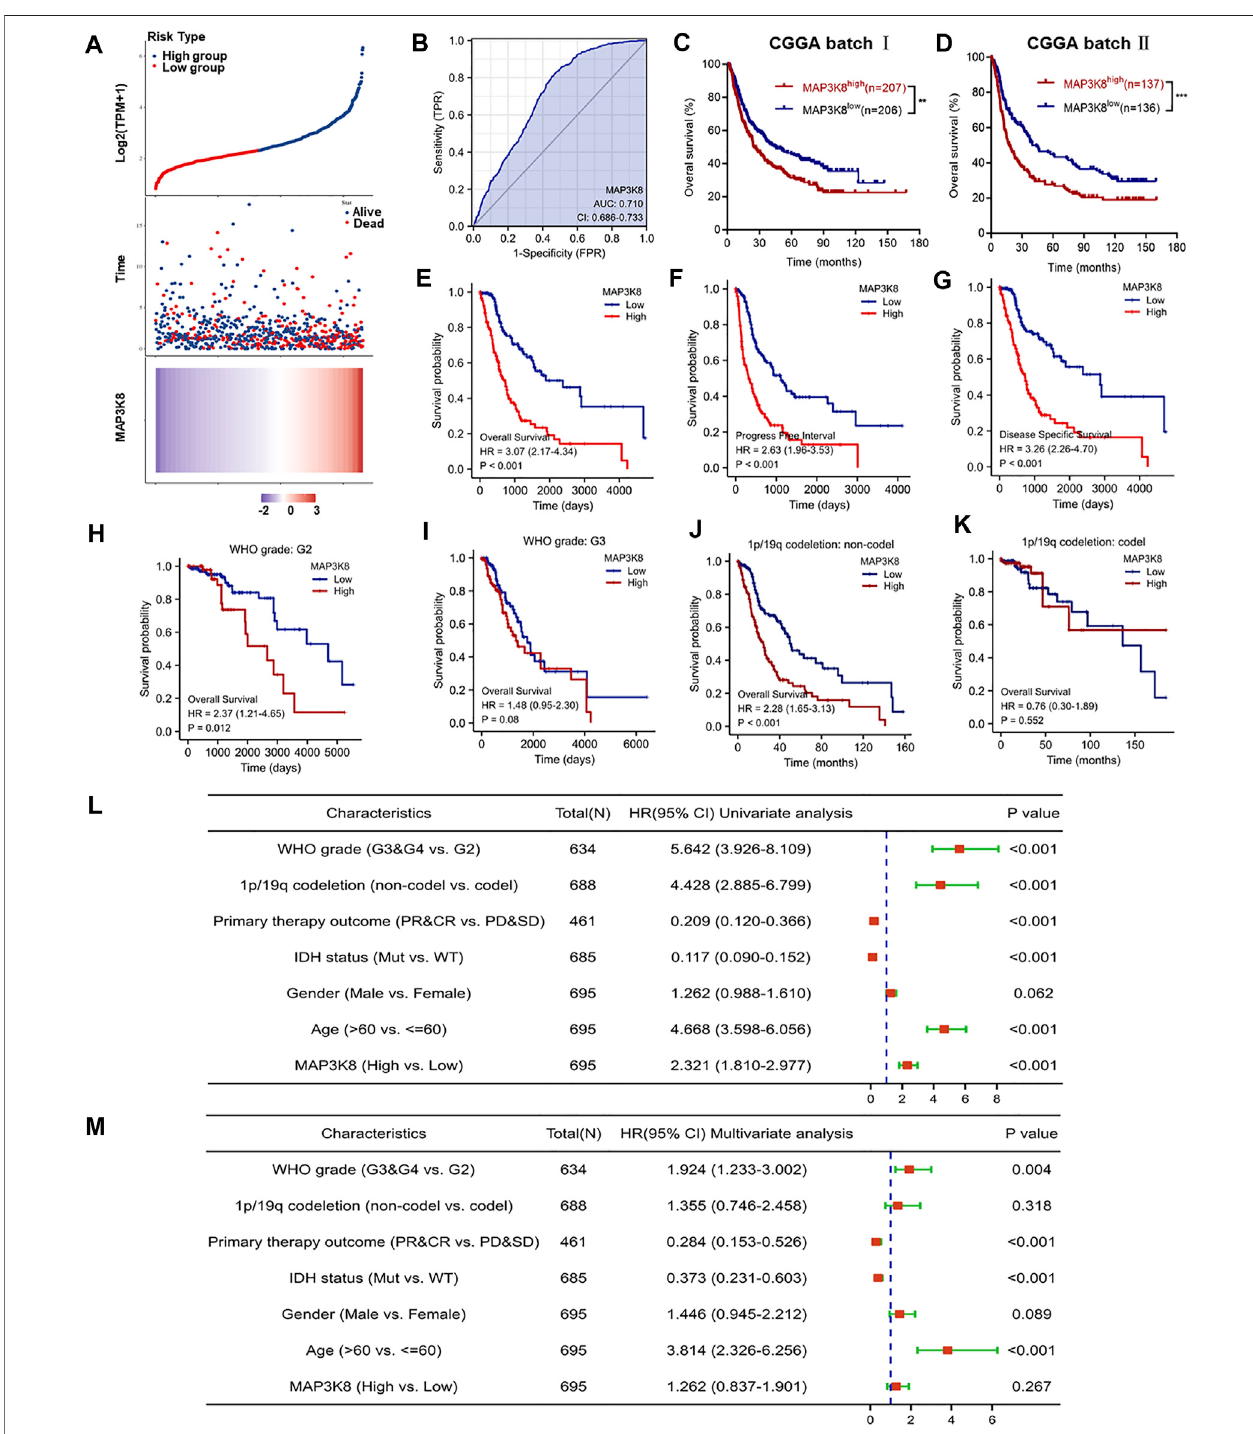
FIGURE 3 | MAP3K8 is a negative prognosticator of survival in glioma. (A) Risk score distribution, survival overview, and heatmap of patients from The Cancer GenomeAtlas(TCGA)cohortsassignedtohigh-andlow-riskgroupsbasedontheriskscores. (B) Receiveroperatingcharacteristic(ROC)curveofMAP3K8expression inthegliomacohort. (C – E) OverallsurvivalanalysisindatasetsfromtheChineseGliomaGenomeAtlas(CGGA)batchI (C) andbatchII (D) andTCGA (E) . (F , G) Disease- speci fi c survival (DSS) (F) and progression-free interval (PFI) (G) in TCGA dataset. (H , I) Survival analysis of MAP3K8 mRNA expression in different WHO grades from TCGA dataset. (J , K) Survival analysis of MAP3K8 mRNA expression in different 1p/19q codeletion status from TCGA dataset. (L , M) Forest plot showing the univariate (L) and multivariate (M) Cox regression models of prognosis for MAP3K8 in TCGA cohort.